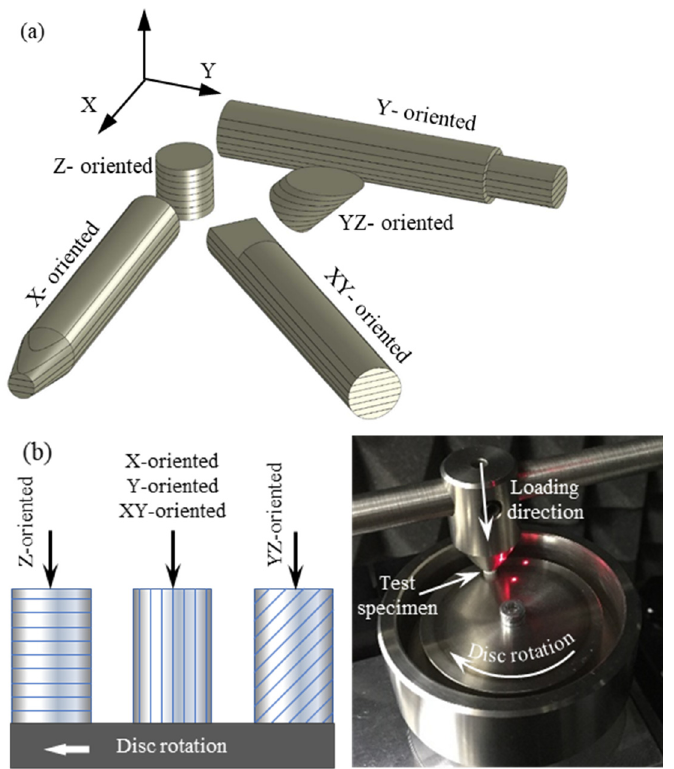
Figure 2. Layer orientations of test specimens ( a ) in the SLS build chamber and ( b ) during experi-